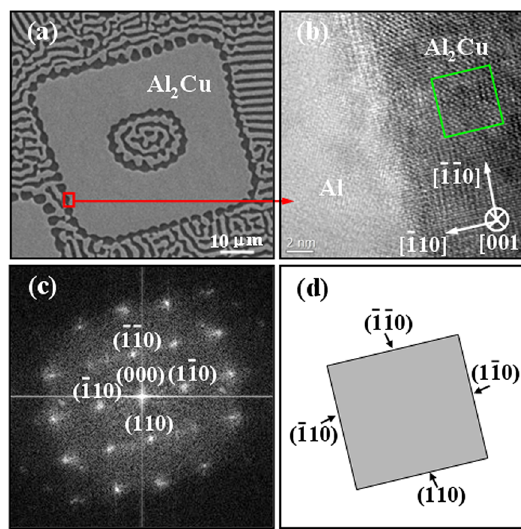
Figure 5. (a) Transverse-section SEM image of rectangle pattern about Al Cu phase crystal in 0.45 mm sample, (b) the HRTEM image 2 of the red region from (a), (c) the selected-area electron diffraction pattern (SAED) from (b): [001] crystal, and (d) {110} facets image of the microstructure of red region. The black area structure can be identified as Al Cu phase in Figure 5(b). A 2 selected-area electron diffraction pattern of Al Cu phase is 2 shown in Figure 5(c). By indexing the diffraction patterns, the {110} facets of Al Cu phase in Figure 5(c) can be clearly 2 identified, which is identical to the previous work 18 . Moreover, this diffraction patterns show the faceted characteristic as the rectangle pattern in Figure 5(d). The bounded surfaces of regular rectangle pattern about Al Cu phase crystal were 2 {110} facets.